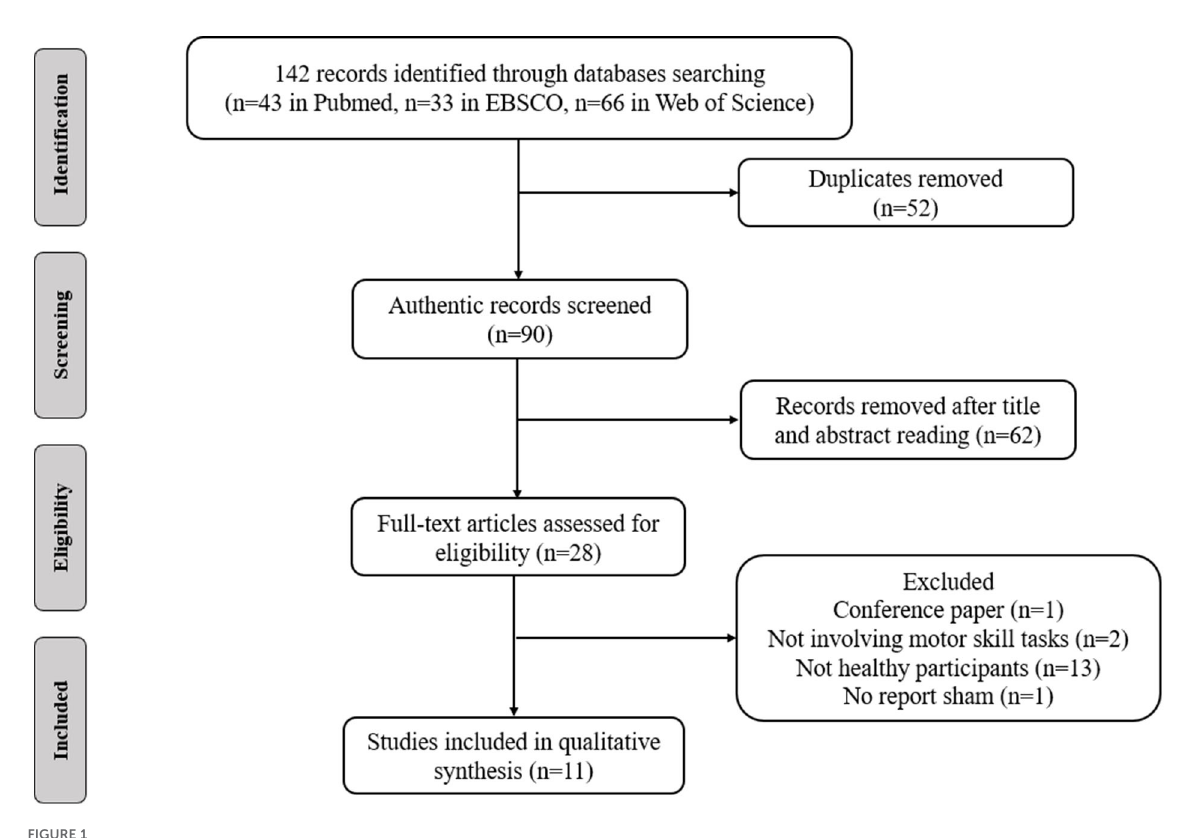
FIGURE1 Flow diagram of the search